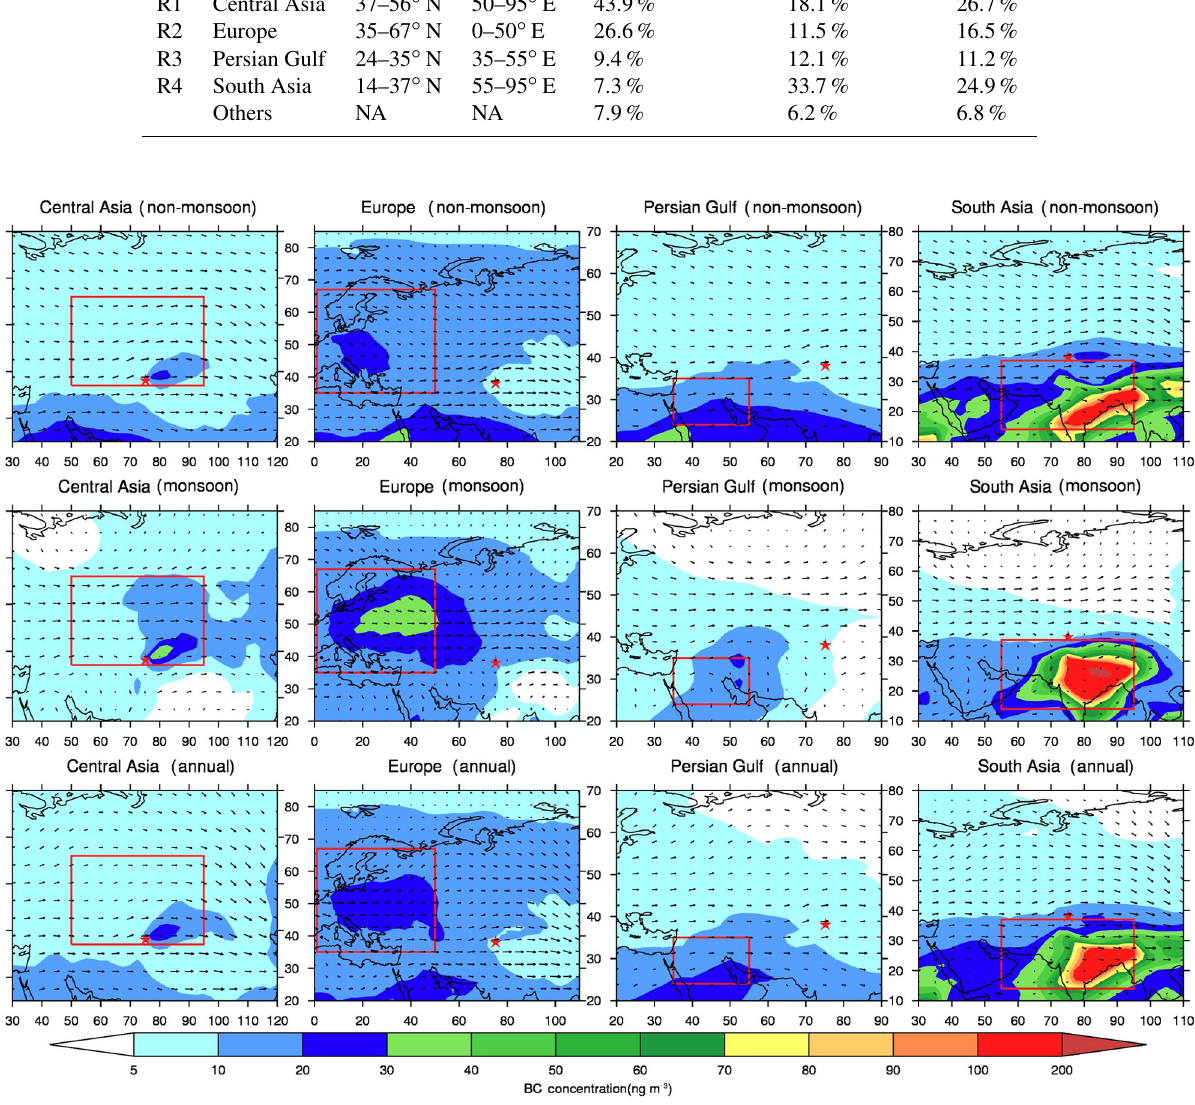
Figure 7. The calculated spatial BC distributions due to individual BC from the four source regions (Central Asia, Europe, Persian Gulf and South Asia) above 5km above the surface during different periods, i.e., monsoon (June–September), non-monsoon (October–May), and annual mean in 1993. The red star is where the study site of Muztagh Ata located. The red boxes indicate the boundary of the four source